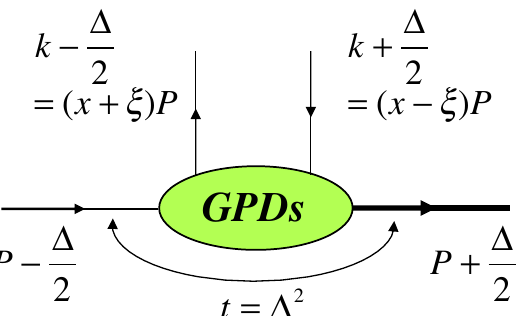
Figure 9. Generalized parton distribution (GPD) kinematics. See text for details.